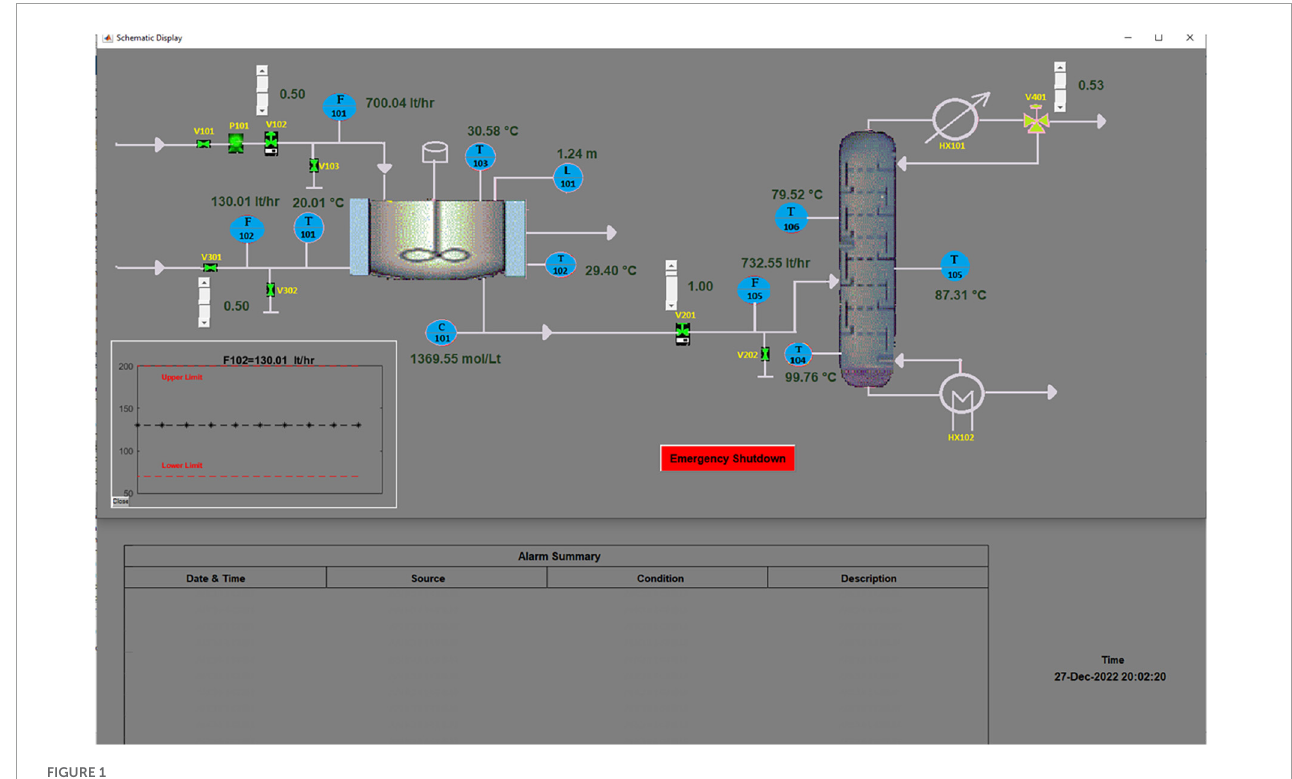
FIGURE1 Human machine interface of the process